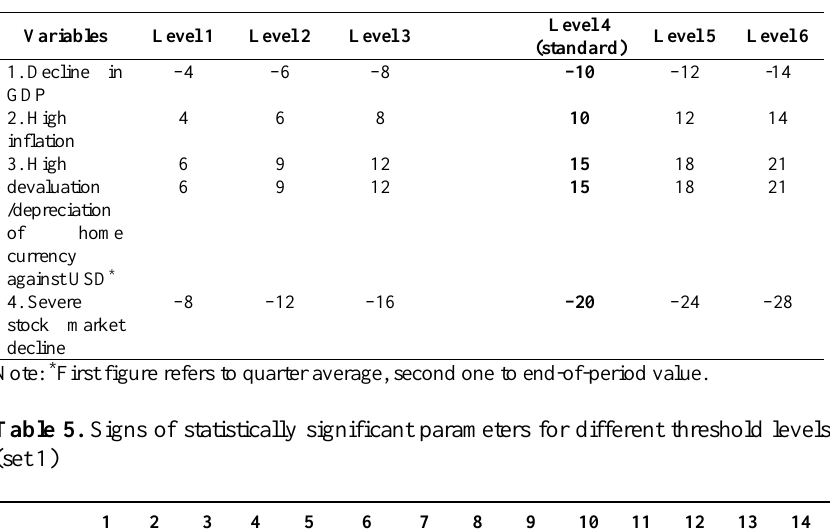
Table 4. Set 2 crisis thresholds (in %)